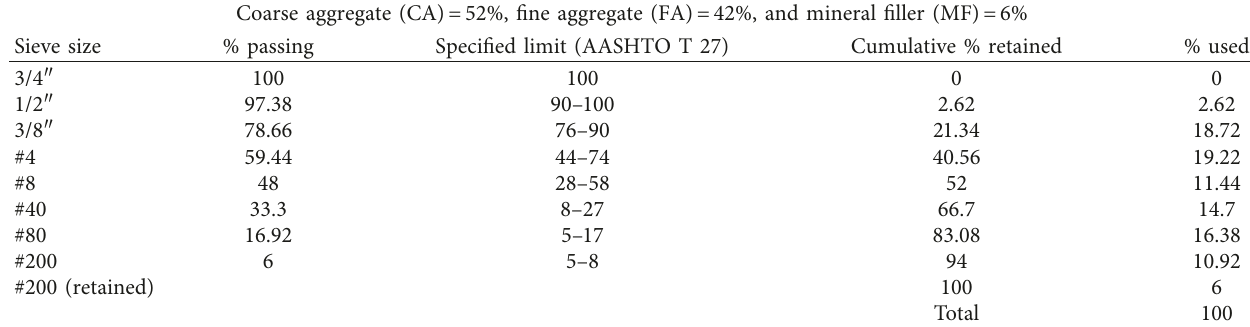
Table 2: Selected combined gradation of aggregate and filler.